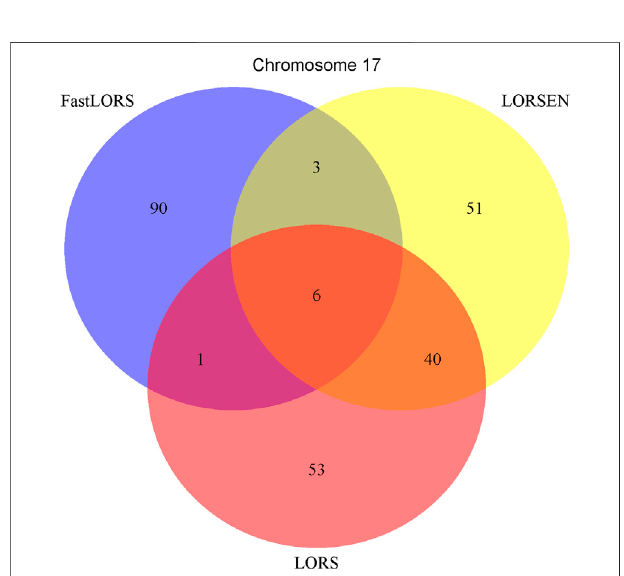
FIGURE 3 | The top 100 SNP-probe pairs identi fi ed by FastLORS, LORSEN, and LORS on Chromosome